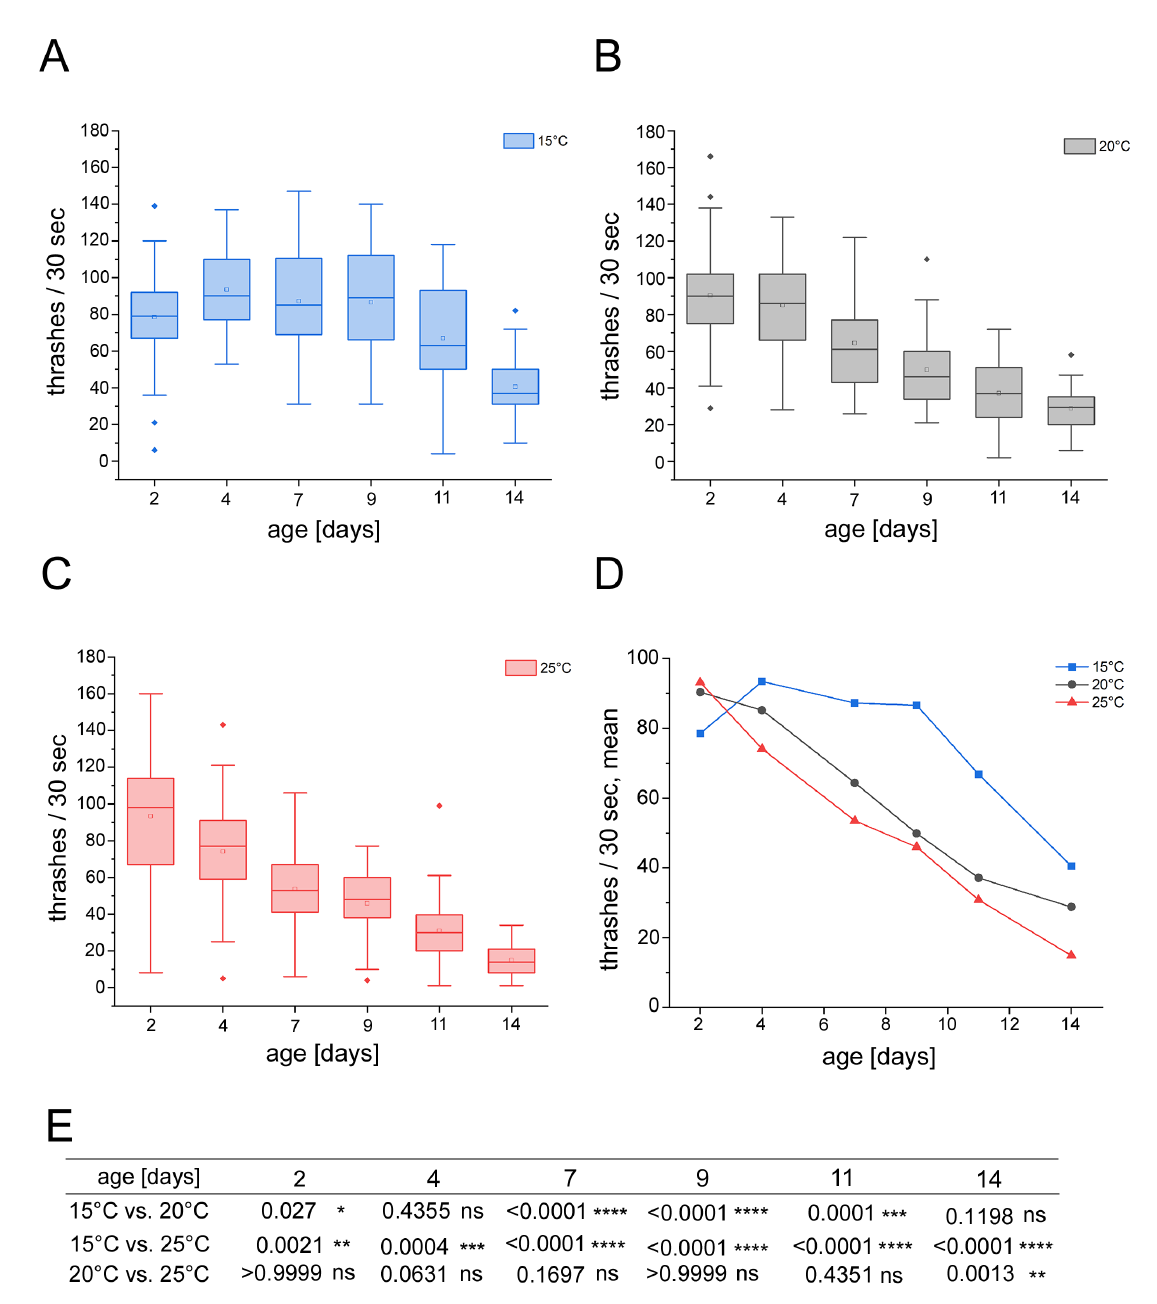
Figure 1: Age-resolved quantification of swimming fitness in adult hermaphrodite C. elegans cultivated at 15, 20 or 25 °C. Wild type C. elegans (N2) were cultured in 96 well microtiter plates in liquid S-com- plete medium containing live E. coli OP50. The worms were exposed to ( A ) 15 °C, ( B ), 20 °C and ( C ) 25 °C. The number of thrashes was counted by stereo microscopy and plotted against the age of adult worms from day 2 (young C. elegans ) until day 14 (old-age C. elegans ) in a boxplot diagram. The box- plots show the median, quantiles, outliers and mean values (small square). ( D ) The mean number of thrashes per 30 seconds ( A-C ) was plotted as a line chart. The color code for the different temperatures is presented on the right. Locomotion fitness was quantified by scoring the number of body bends per 30 seconds. Worms which did not display at least one thrashing movement were censored. ( E ) Signifi- cance (p) was compared between the exposure temperatures at different days (Kruskal-Wallis ANOVA with Dunn’s post hoc test). All experiments were performed in triplicate. n ≥ 25 – 75. C, Celsius; d, days; ns, not